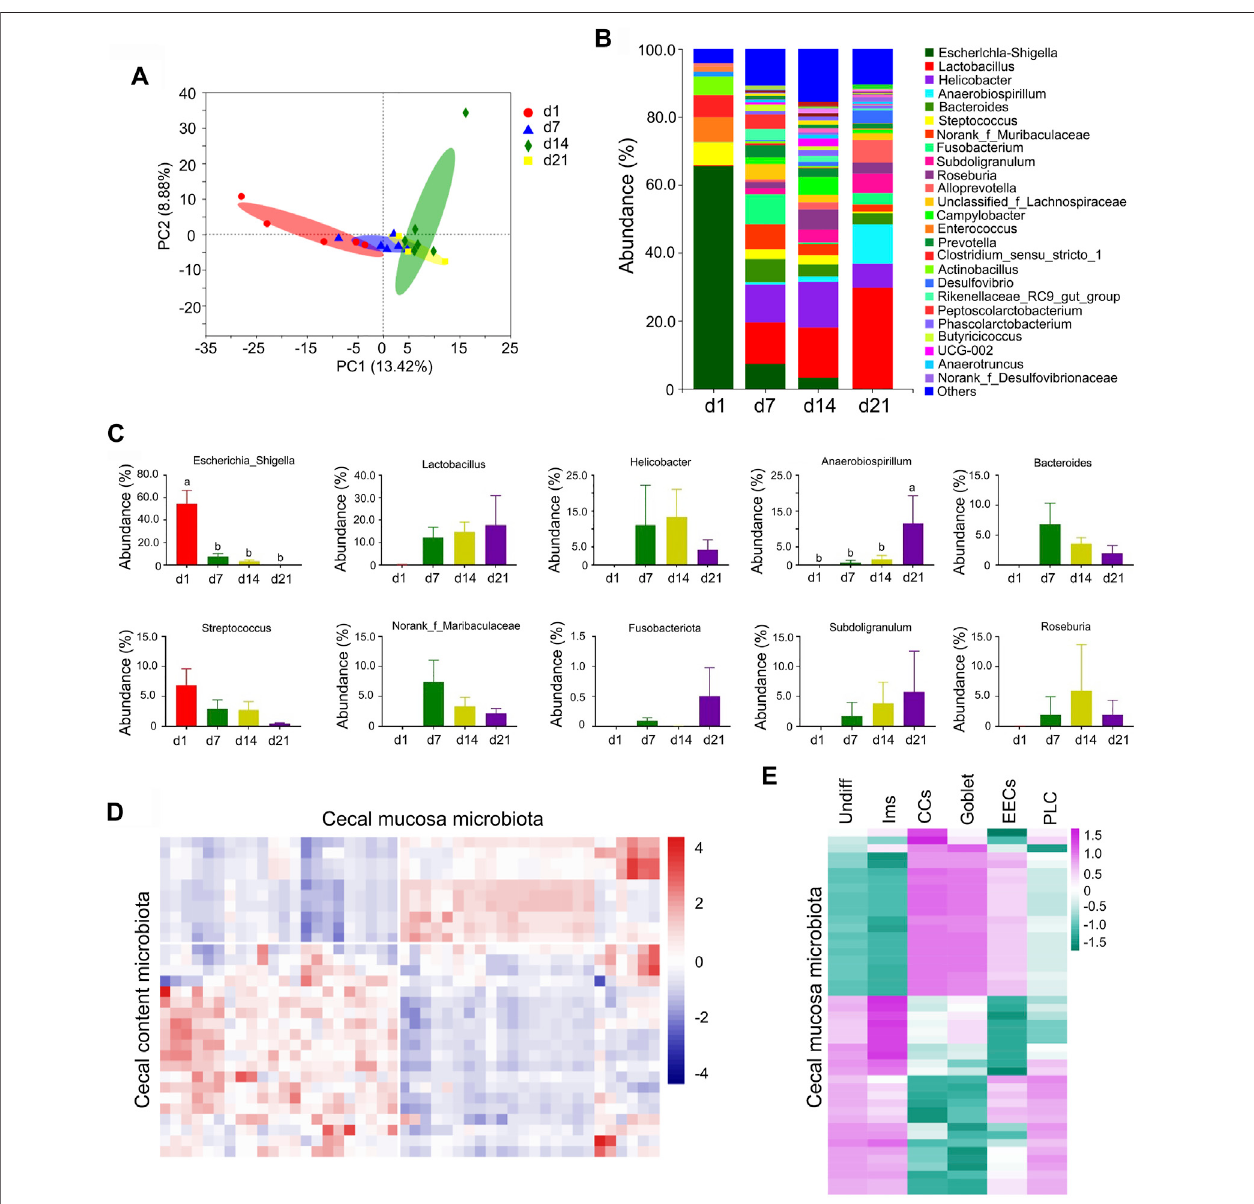
FIGURE 9 | Changes in cecal mucosa microbiota. (A) The PCA of the micro fl ora in cecal mucosal samples from different time points. The X-axis shows the PC1 while the Y-axis presents the PC2. (B) Differences of bacterial abundance at the genus level. The X-axis shows the time points while the Y-axis presents the relative proportion. (C) Relative proportion of the 10 major microbiotas. The X-axis shows the time points while the Y-axis presents the relative proportion. (D) Pearson correlation of the proportion of different microbiota in cecal mucosa and cecal content. (E) Pearson correlation of the proportion of different microbiota in cecal mucosa and the proportion of different clusters of